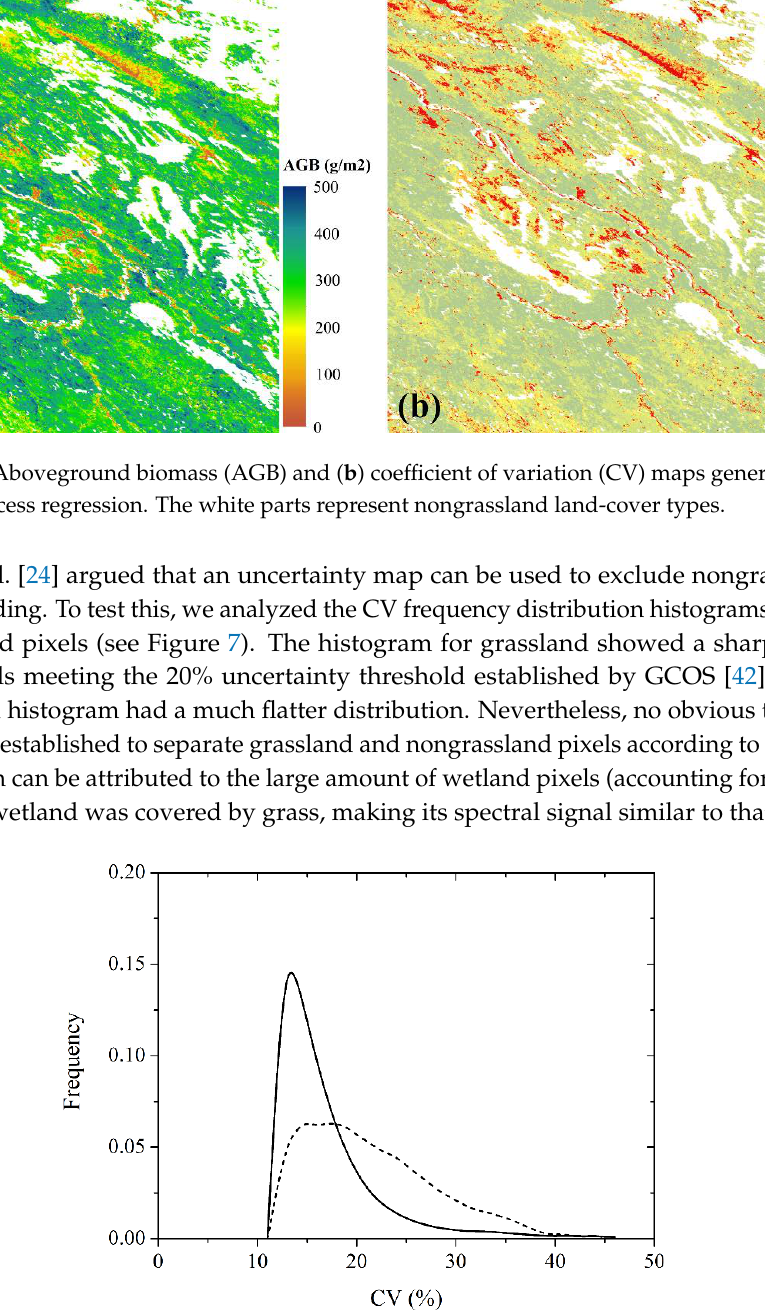
Figure 7. CV frequency distribution histograms for grassland (solid line) and nongrassland (dashed line).